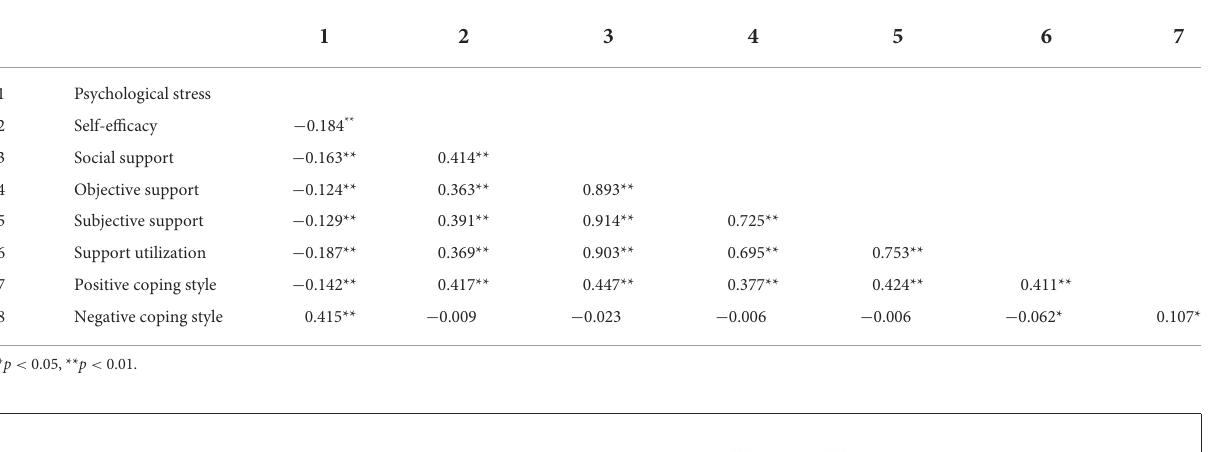
TABLE 3 The correlation between psychological stress, self-efficacy, social support and coping styles.